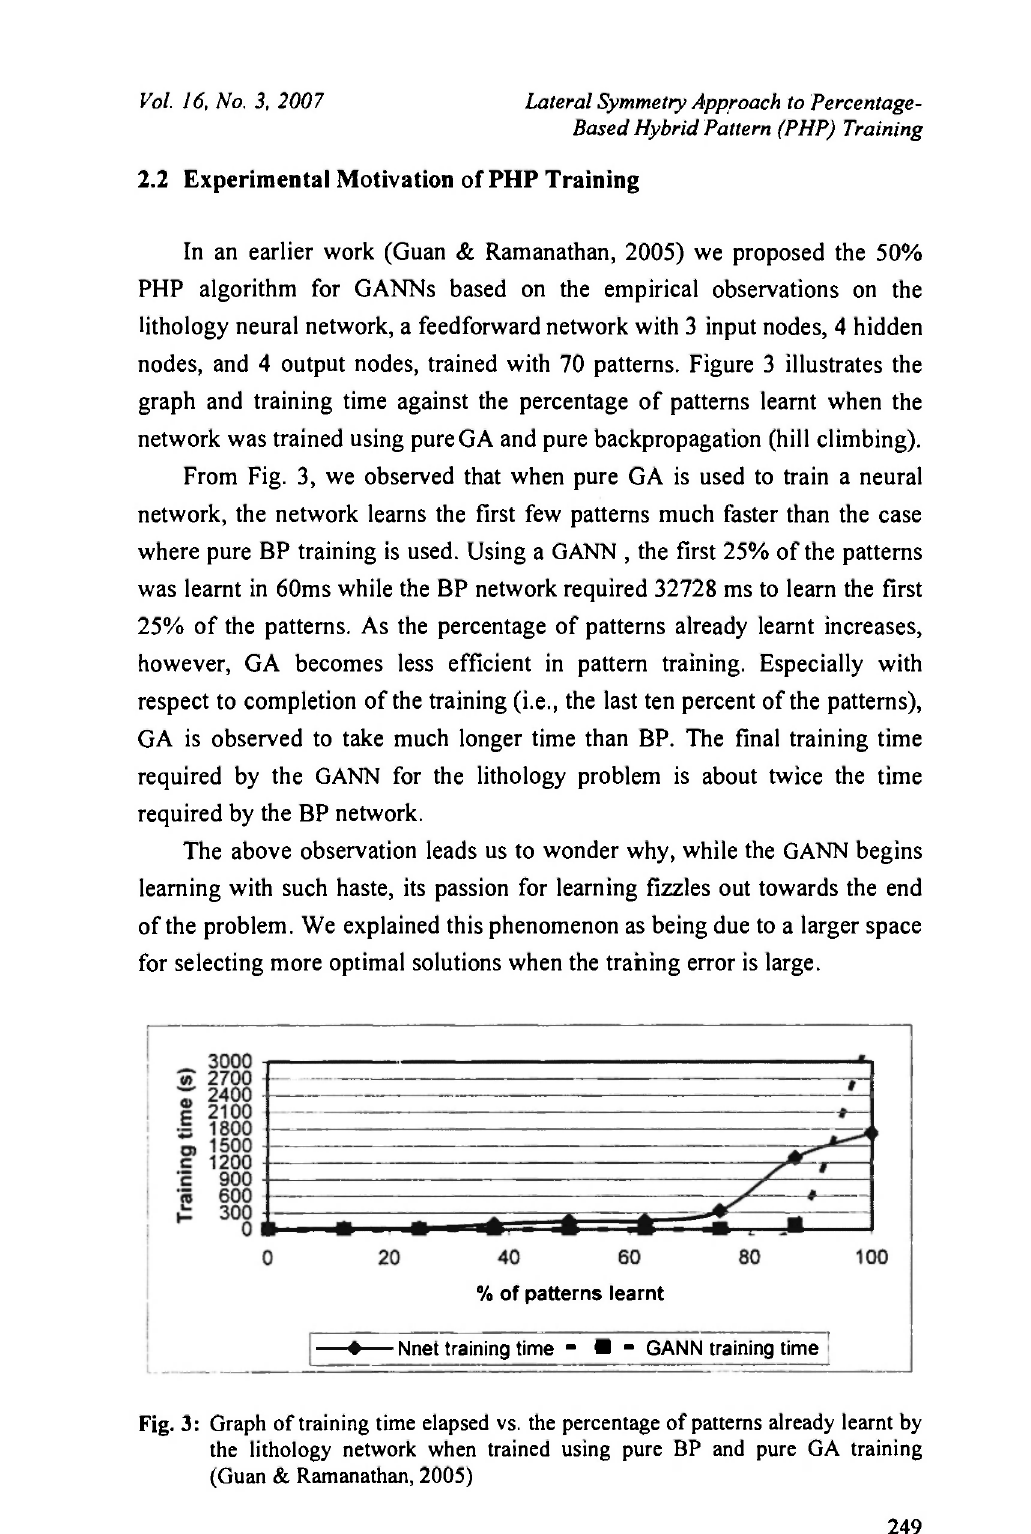
Fig. 3: Graph of training time elapsed vs. the percentage of patterns already learnt by the lithology network when trained using pure BP and pure GA training (Guan & Ramanathan,